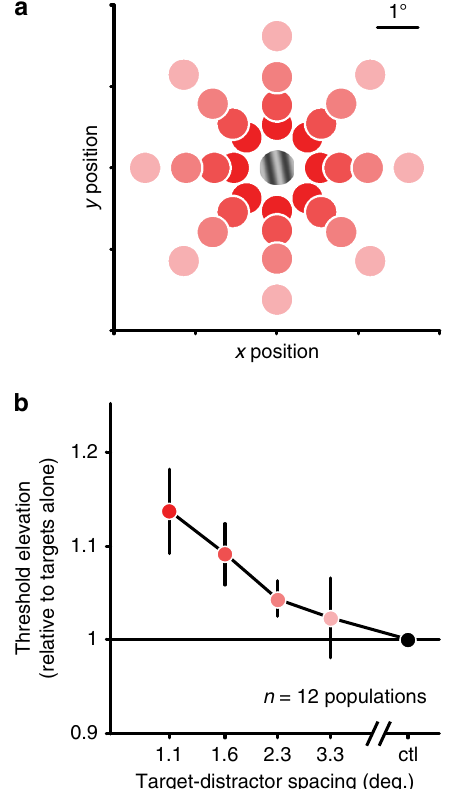
Fig. 4 Effect of target – distractor separation. a Across trials, we varied the spacing of targets and distractors, from distant (3.28° center-to-center distance, pink) to near (1.06°, red). Trials were randomly interleaved. b Average thresholds for responses to targets with distractors, normalized to thresholds for targets alone. Error bars represent s.e.m. across populations. Source data are provided as a source data fi le.